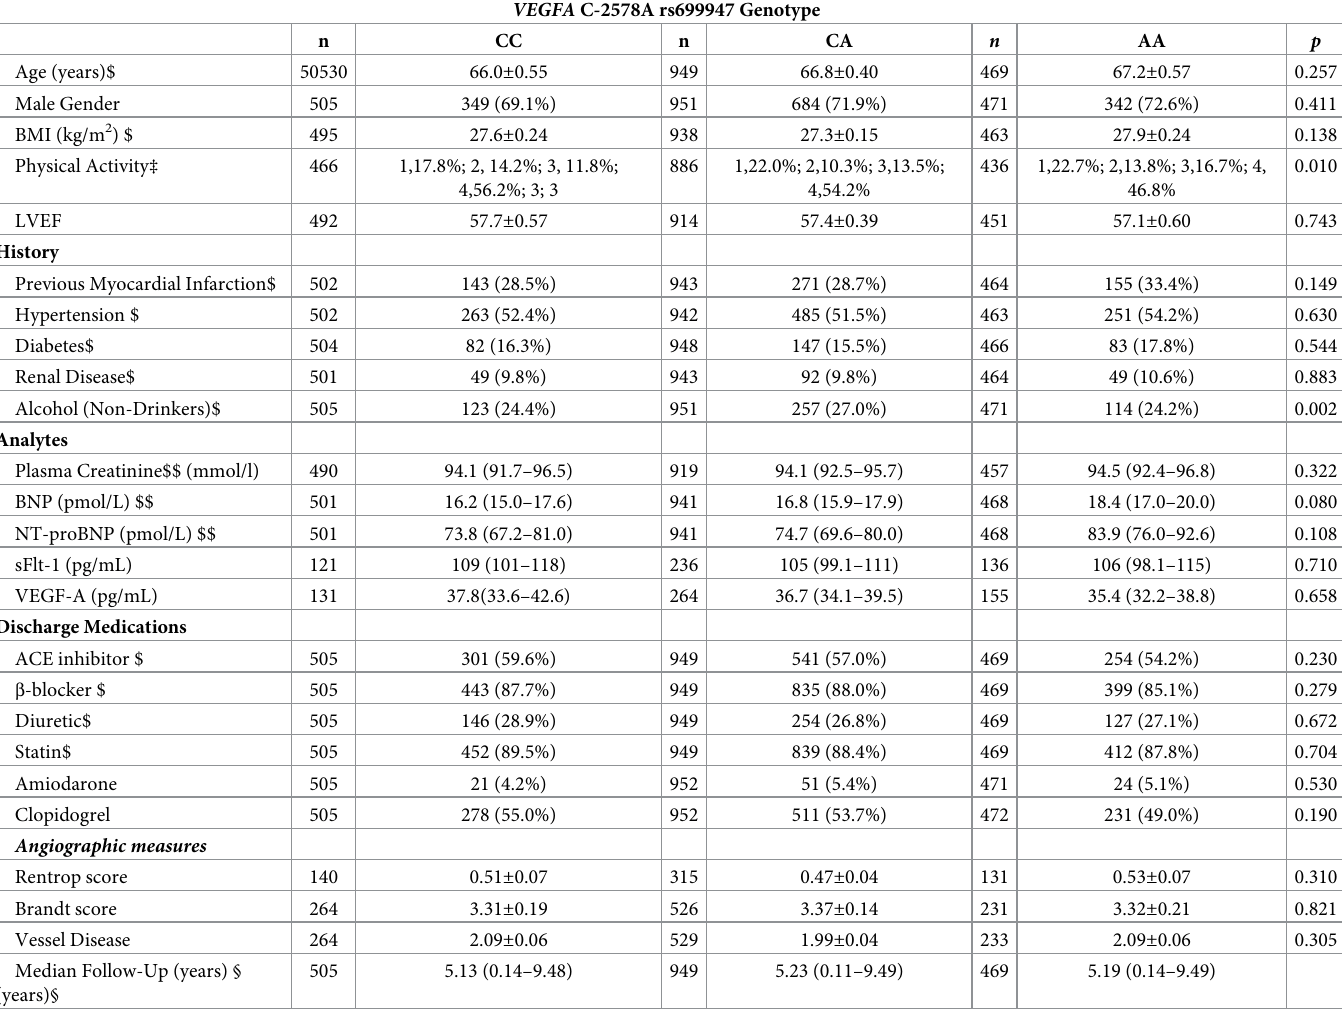
Table 2. Baseline characteristics, drug treatment and neurohormonal data for CDCS patients stratified by VEGF SNP genotype